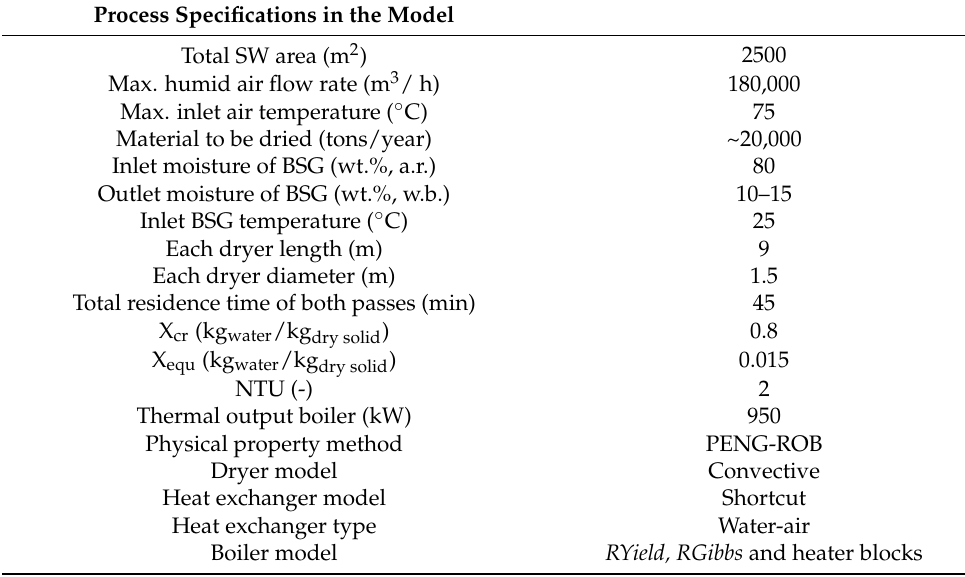
Table 2. Summary of the low-temperature drying plant process specifications (reference design) used in Aspen Plus